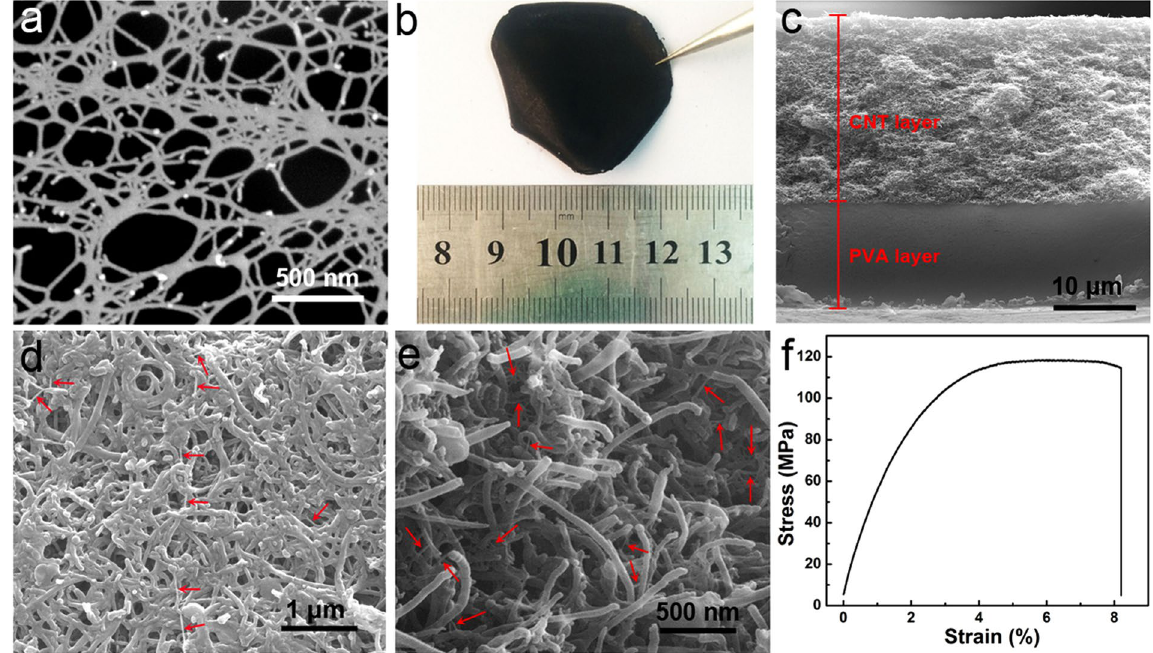
Figure 2. Structure characterization of the PBONF-reinforced CNT/PVA bilayer actuators. ( a ) SEM image of PBONFs. ( b ) Photograph of a PBONF-reinforced CNT/PVA bilayer film with the diameter of ca. 4 cm. ( c ) Cross-sectional SEM image of the bilayer actuator. ( d ) Top-view and ( e ) cross-sectional SEM images of the PBONF-reinforced CNT layer. Red arrows mark PBONFs distributed in the CNT network. ( f ) Tensile stress- strain curve of the PBONF-reinforced CNT/PVA bilayer actuator at the RH of